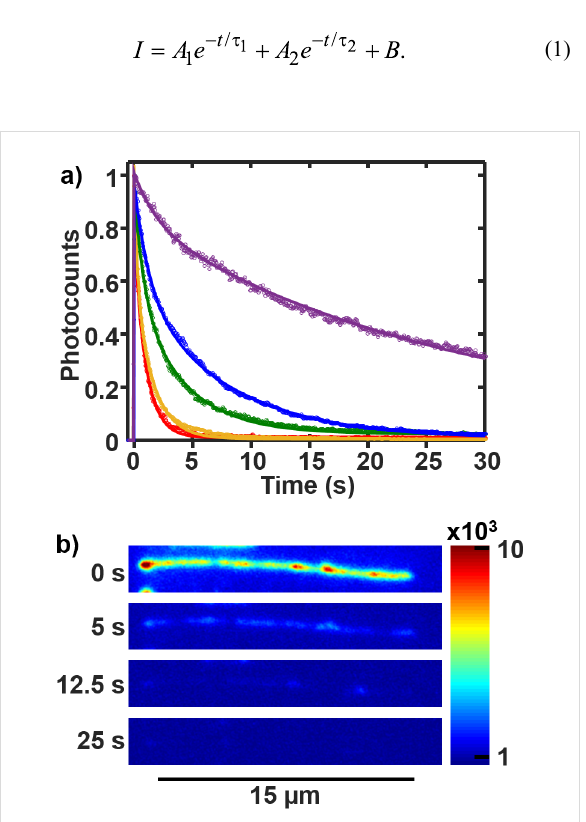
Figure 5: (a) The time trace of the photocounts per micrometer of a single DNA strand for power densities of 62 W cm − 2 (red), 38 W cm − 2 (orange), 23 W cm − 2 (green), 10 W cm − 2 (blue), and 1.9 W cm − 2 (violet). (b) Image of a DNA molecule at different times of the video. All images have the same color scale. A laser power density of 38 W cm − 2 was